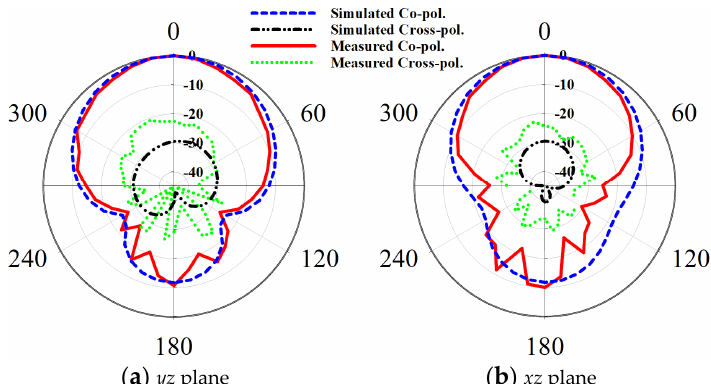
Figure 5. Normalized radiation patterns of screen-printed antenna at 2.4 GHz.